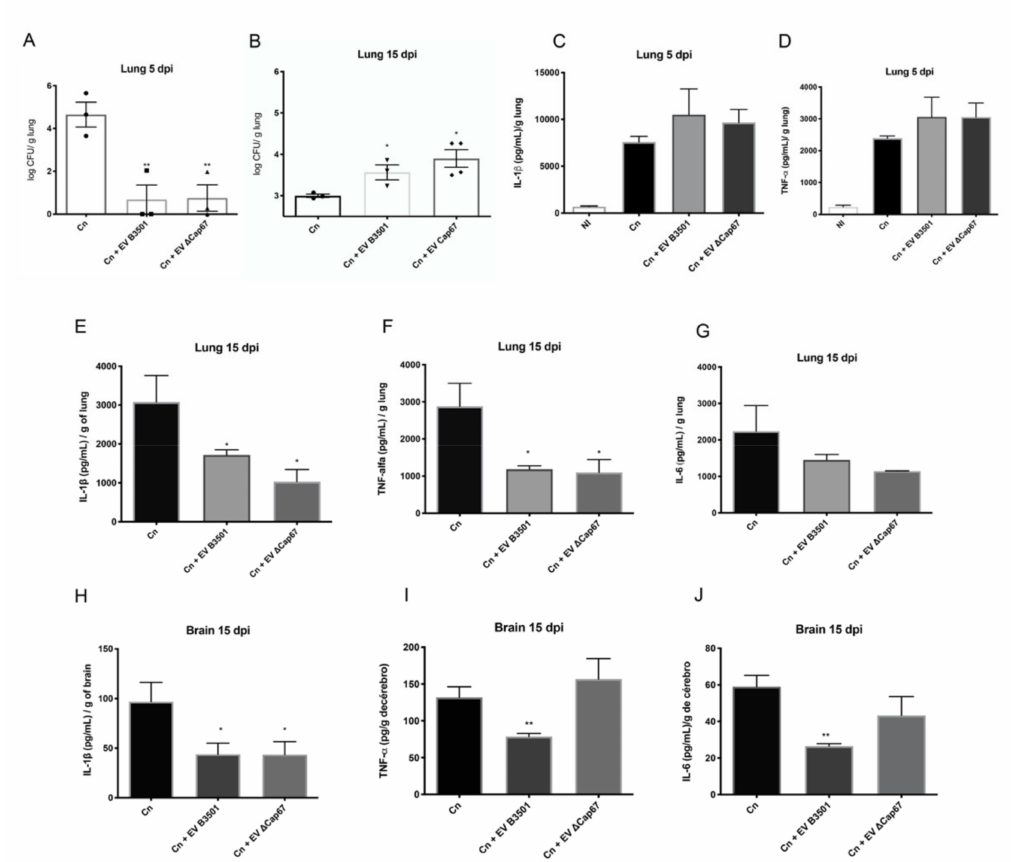
Figure 3. Treatment with EVs produced in a rich medium induces an anti-inflammatory response in the lungs of infected mice after 15 days of infection with an increase of the fungal load in the lungs. C57Bl / 6 mice were infected with C. neoformans (2 × 10 4 cells / animal) intratracheally and treated intranasally with 50 µ g of EVs (protein content) produced in SDB 100%. Mice were treated one and three days post-infection (dpi) and euthanized 5 dpi ( A , C , D ) or treated two and four dpi and euthanized 15 dpi ( B , E – J ). Lungs were macerated and spread on Sabouraud dextrose agar (SDA) plates and were cultivated for 3 days at 30 ◦ C to quantify colony forming units (CFUs) ( A , B ). The macerated supernatants were quantified for cytokine content with ELISA assay ( C – J ). * indicates p < 0.05, ** indicates p < 0.01 (significant di ff erence comparing with Cn group), according to one-way ANOVA. The data are expressed as the mean ± SEM of triplicates and represent at least three independent